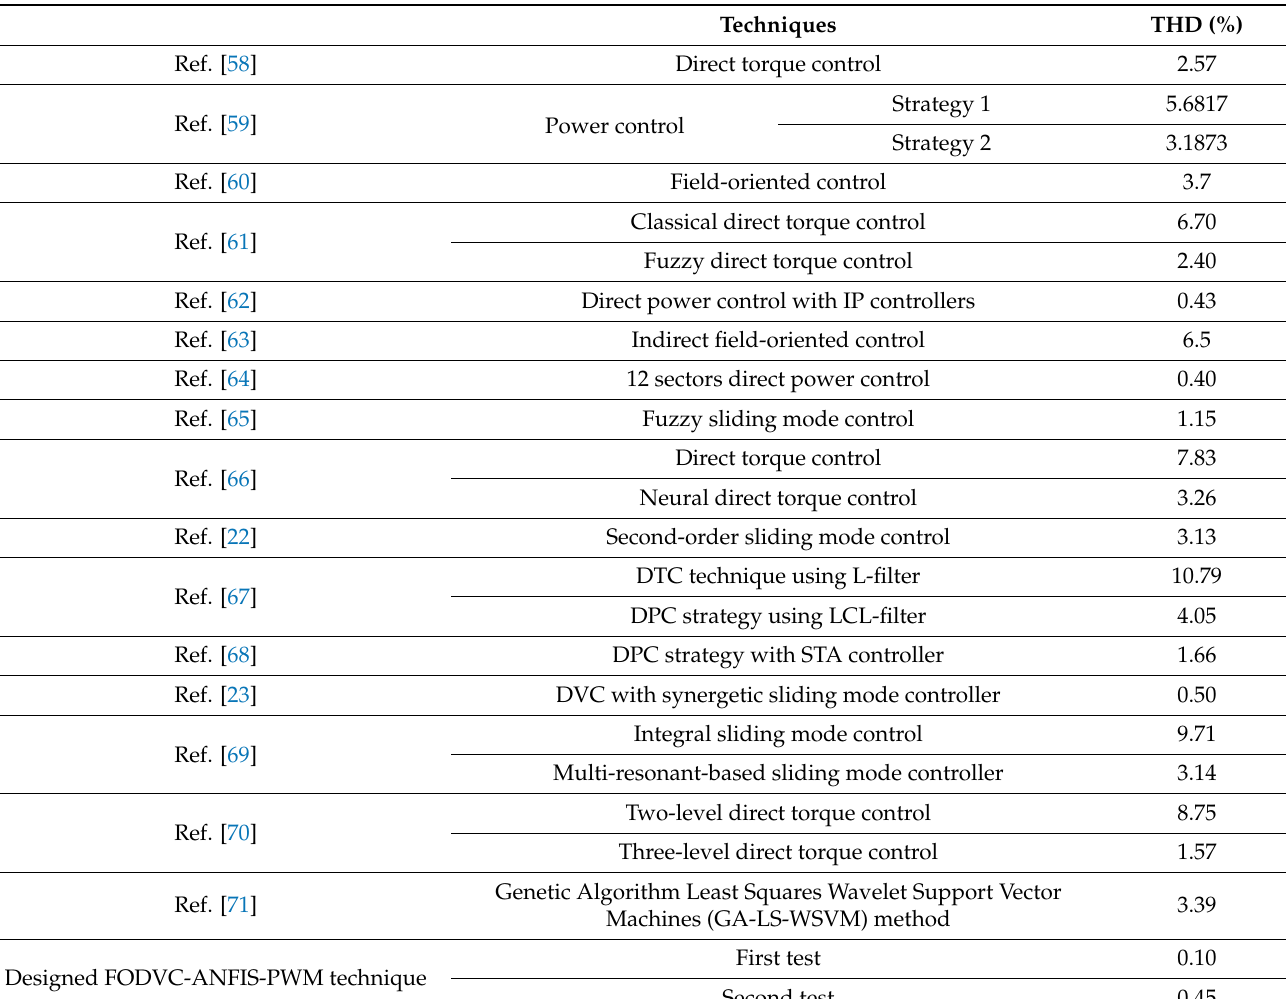
Table 4. A comparative study between the designed FODVC-ANFIS-PWM strategy and other works in terms of the value of